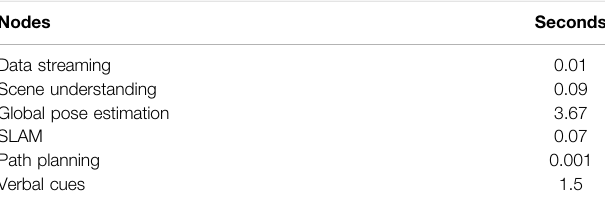
TABLE 6| Theprocessingtimeofindividualnodes ismeasured toprobe real-time performance.